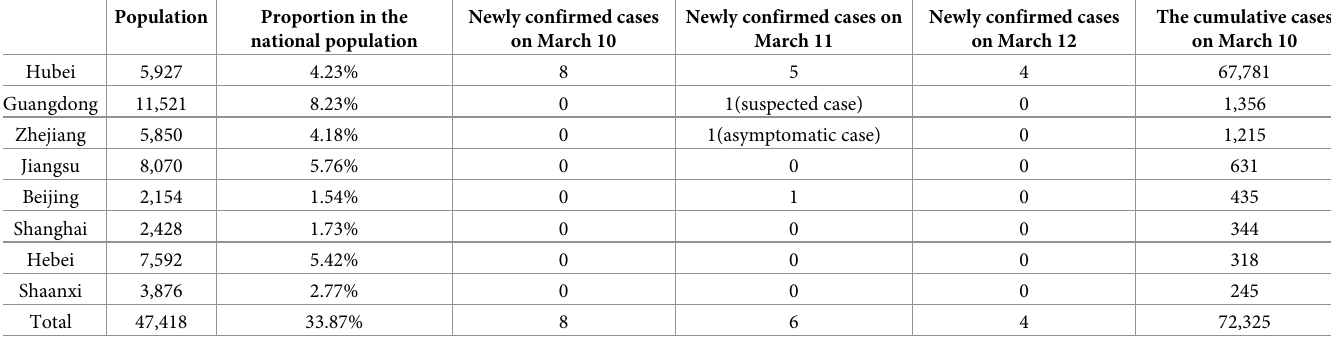
Table 1. The population and daily figure of COVID-19 cases in sample areas. Population Proportion in the national